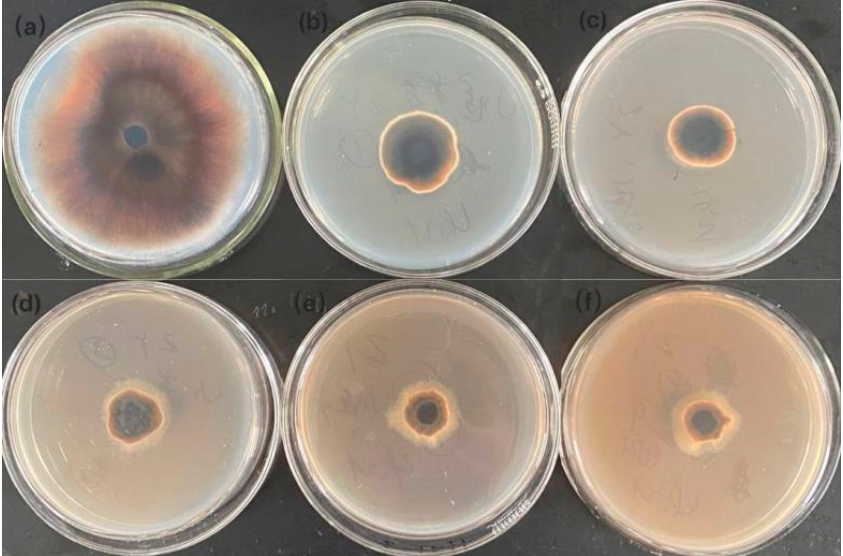
Figure 5. Inhibition of the colony growth of silver nanoparticles against B. maydis . ( a ) control isolate, ( b – f ) various concentration (20, 40, 60, 80, and 100 μ L ∙ mL − 1 , v/v ) of silver nanoparticles.